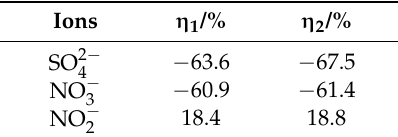
Table 4. The values of corrosion efficiency ( η